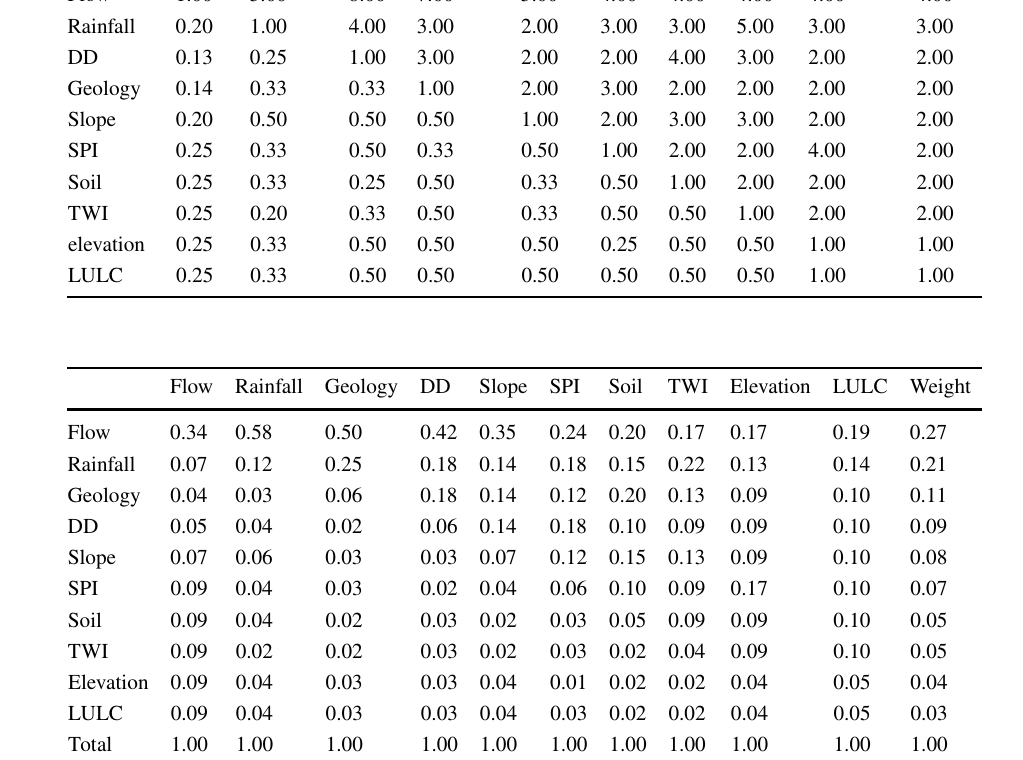
Table 2 Pairwise comparison matrix